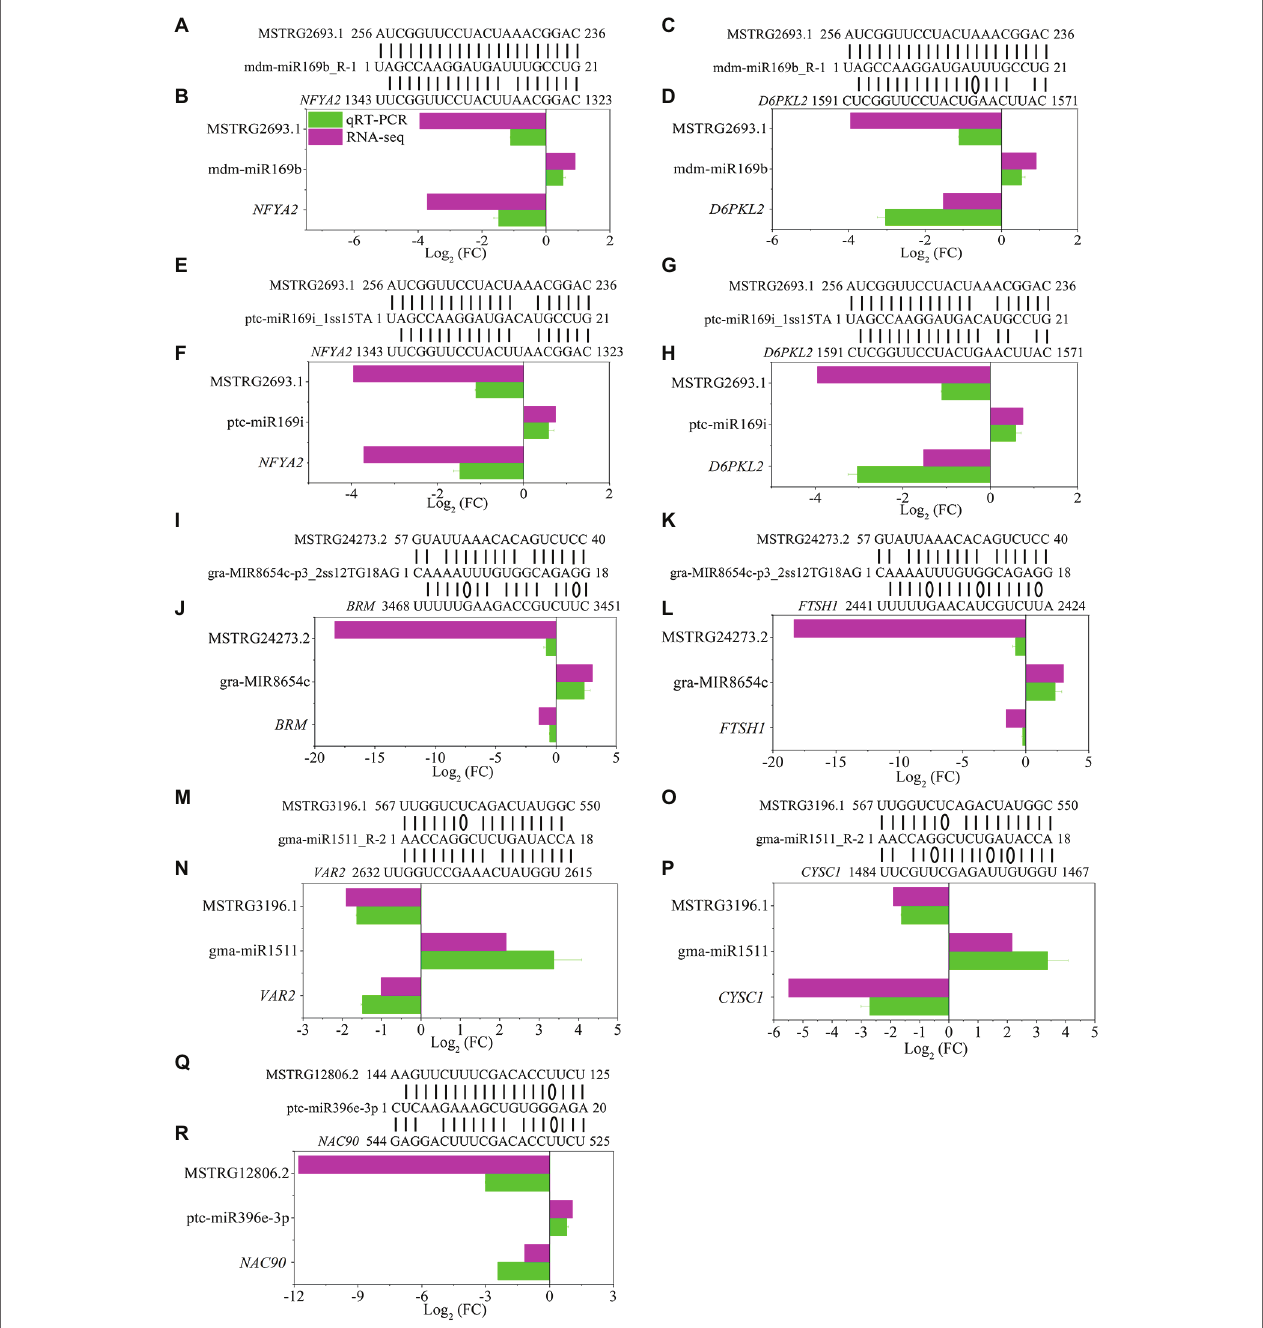
FIGURE 7 | Validation of significantly differentially expressed lncRNAs, miRNAs and mRNAs under different nitrogen fertilization treatments in P. x canescens determined by sRNA-seq and RT—qPCR. (B,D,F,H,J,I) represent NO 3- vs. NH 4 NO 3 comparsion and (N,P,R) represent NH 4+ vs. NH 4 NO 3 comparsion. The bars show the mean ± SE (n = 4). Sequence complementary positions of predicted lncRNA-miRNA-mRNA pairs (A,C,E,G,I,K,M,O,Q) . Details regarding the abbreviations of mRNAs are listed in Supplementary Table S10